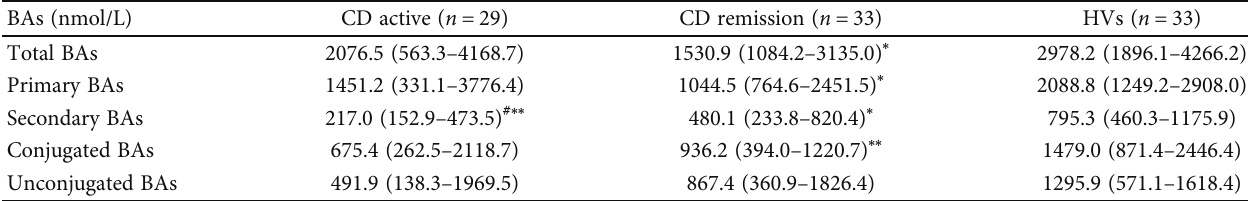
Table 2: Concentrations of di ff erent bile acids in the entire